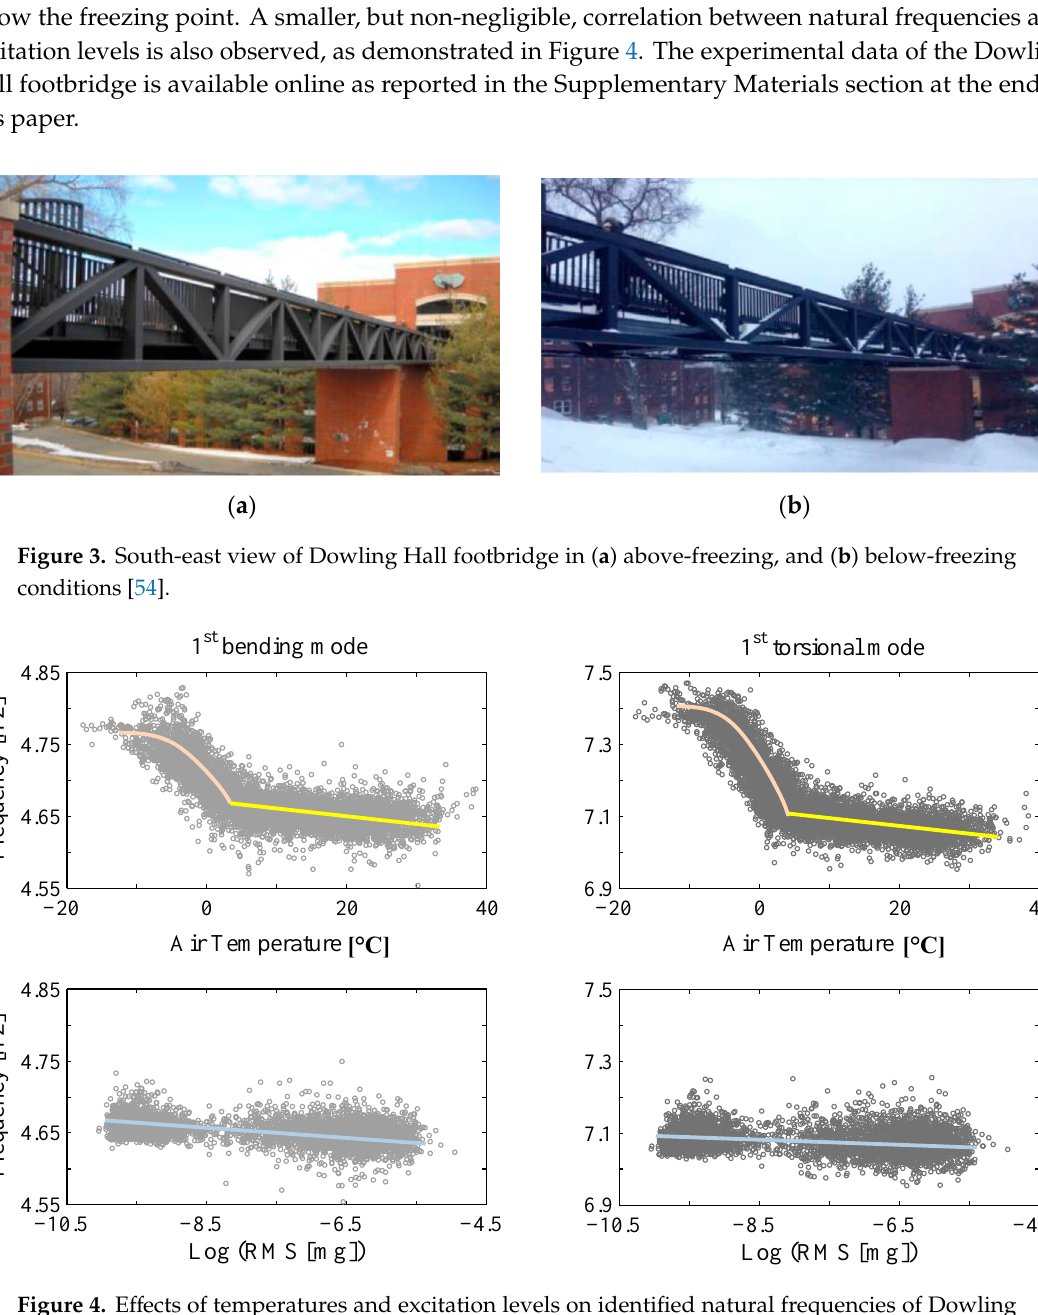
Figure 4. Effects of temperatures and excitation levels on identified natural frequencies of Dowling Hall footbridge.